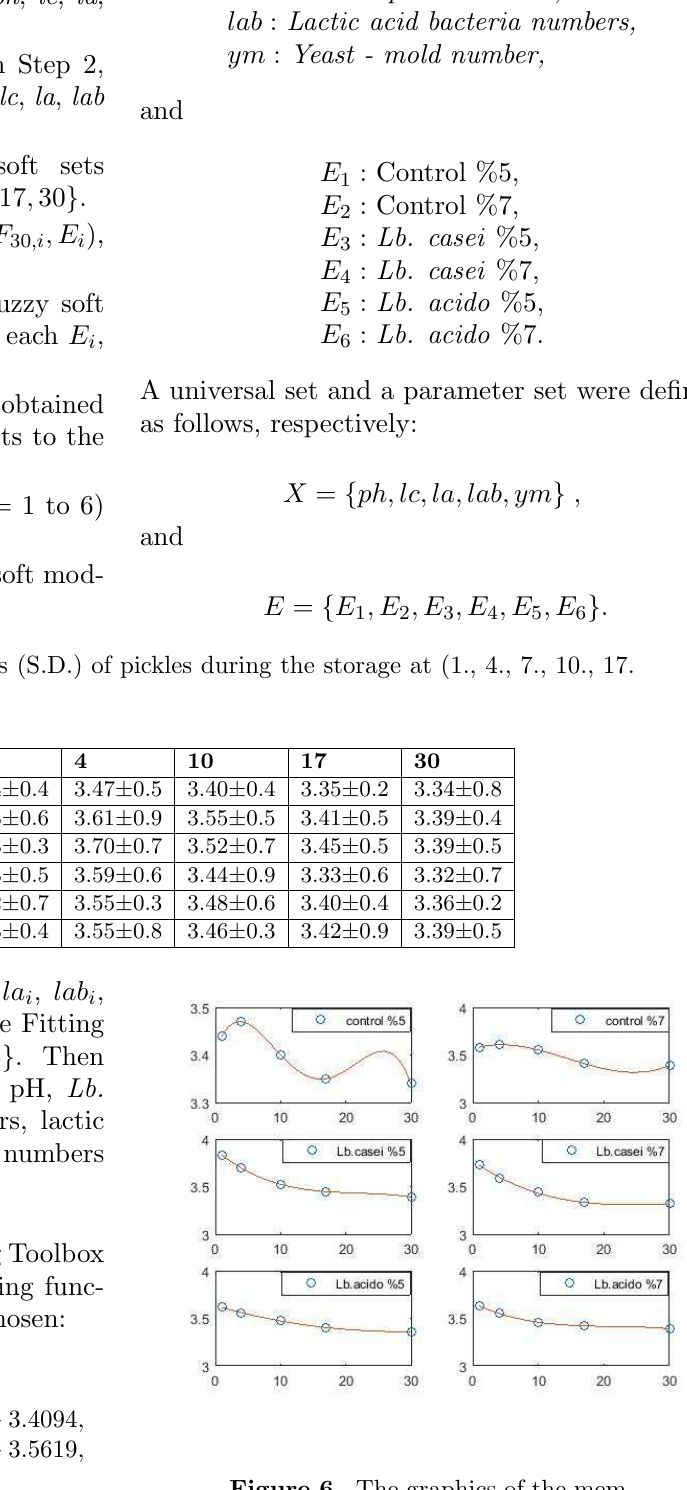
Figure 6. The graphics of the mem- bership functions for pH value (the x- axis represent the days and the y-axis represent the pH